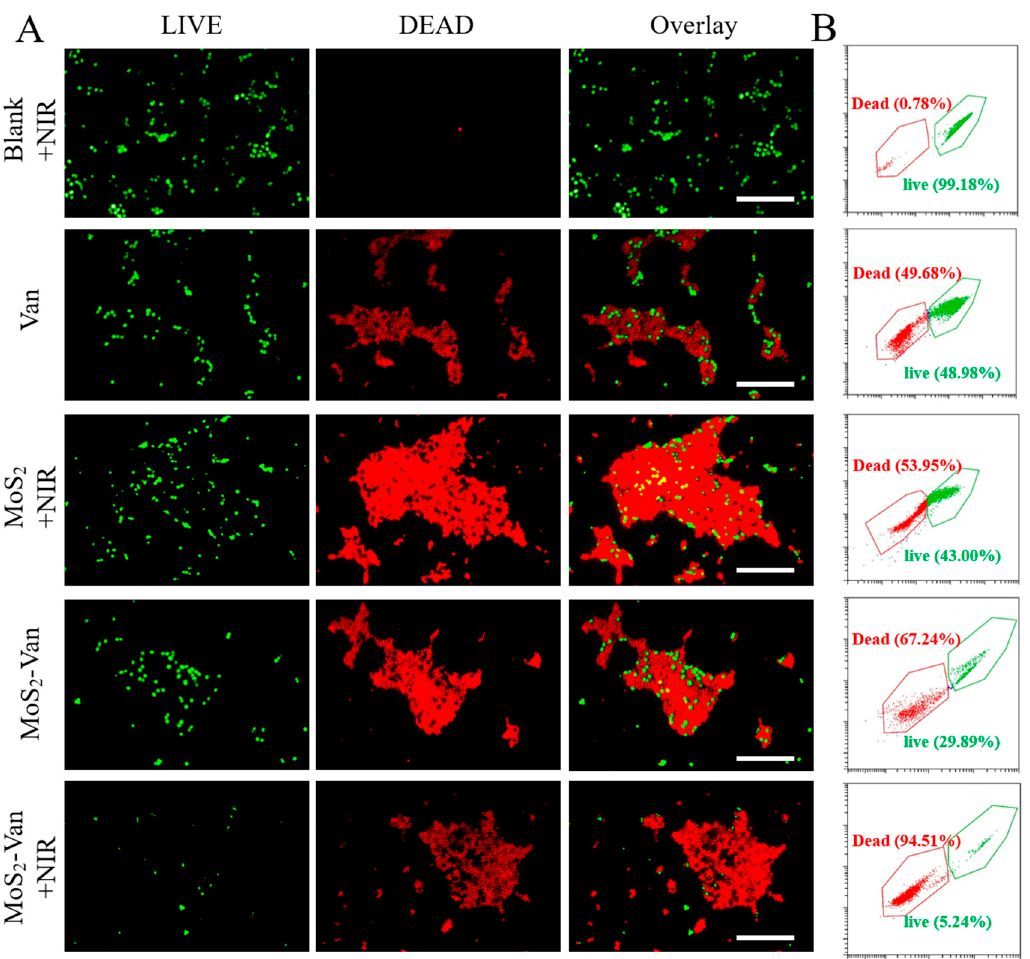
Figure 6. Confocal fluorescence microscopy assay ( A ). S. aureus cultures after treatment with MoS 2 - Van NPs + NIR (100 µg/mL). Van solution (1 µg/mL), MoS 2 NPs + NIR (100 µg/mL) and MoS 2 -Van (100 µg/mL) served as control groups. PBS served as a blank group. The cells were stained with SYTO 9 (green fluorescence) and PI (red fluorescence) for 30 min. The cells underwent NIR irradiation at 808 nm (1.5 W/cm 2 , 6 min). The results of the apoptotic assay by flow cytometry analysis were statistically analyzed by CytExpert software (version 2.4.0.28) ( B ). Scale bar = 15 µm. The data are expressed as mean ± SD ( n = 3).